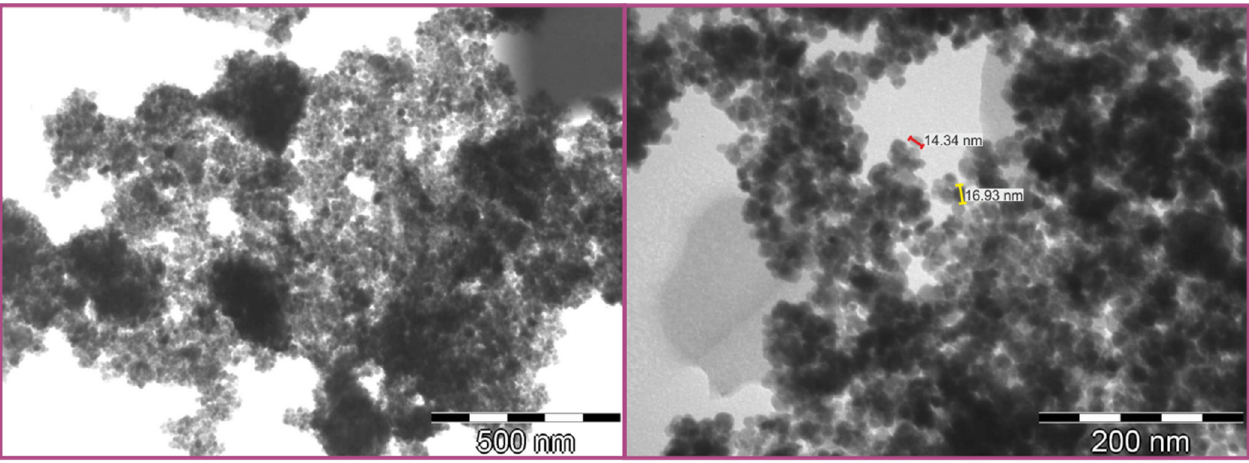
Figure 5. TEM images of Pd-Fe 3 O 4 -CWH nanocatalyst. Figure 4. TEM images of Pd-Fe